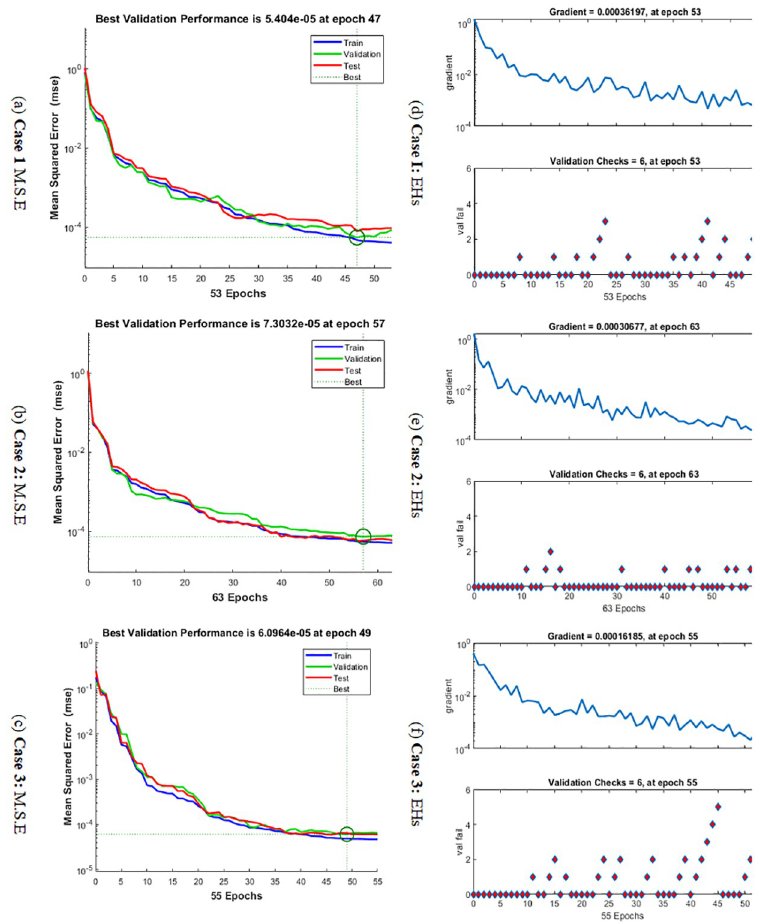
Fig 4. Performances of MSE (a-c) and STs values (d-f) for solving the infection FONPPS. (a) Case 1 M.S.E (b) Case 2 : M.S.E (c) Case 3 : M.S.E (d) Case I : EHs (e) Case 2 : EHs (f) Case 3 :